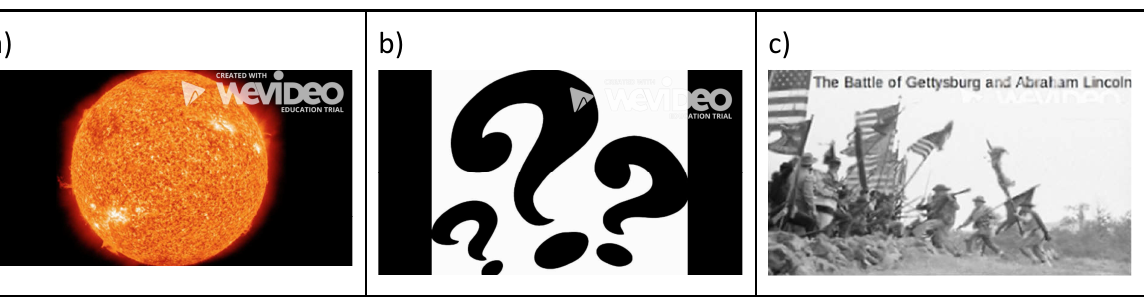
Figure 3: Varied image use in student digital stories; (a) Topical image from Rachel’s digital story about teaching on the stars, (b) Emotive image used in Rachel’s digital story, (c) Screenshot of slides used in Vera’s digital story.